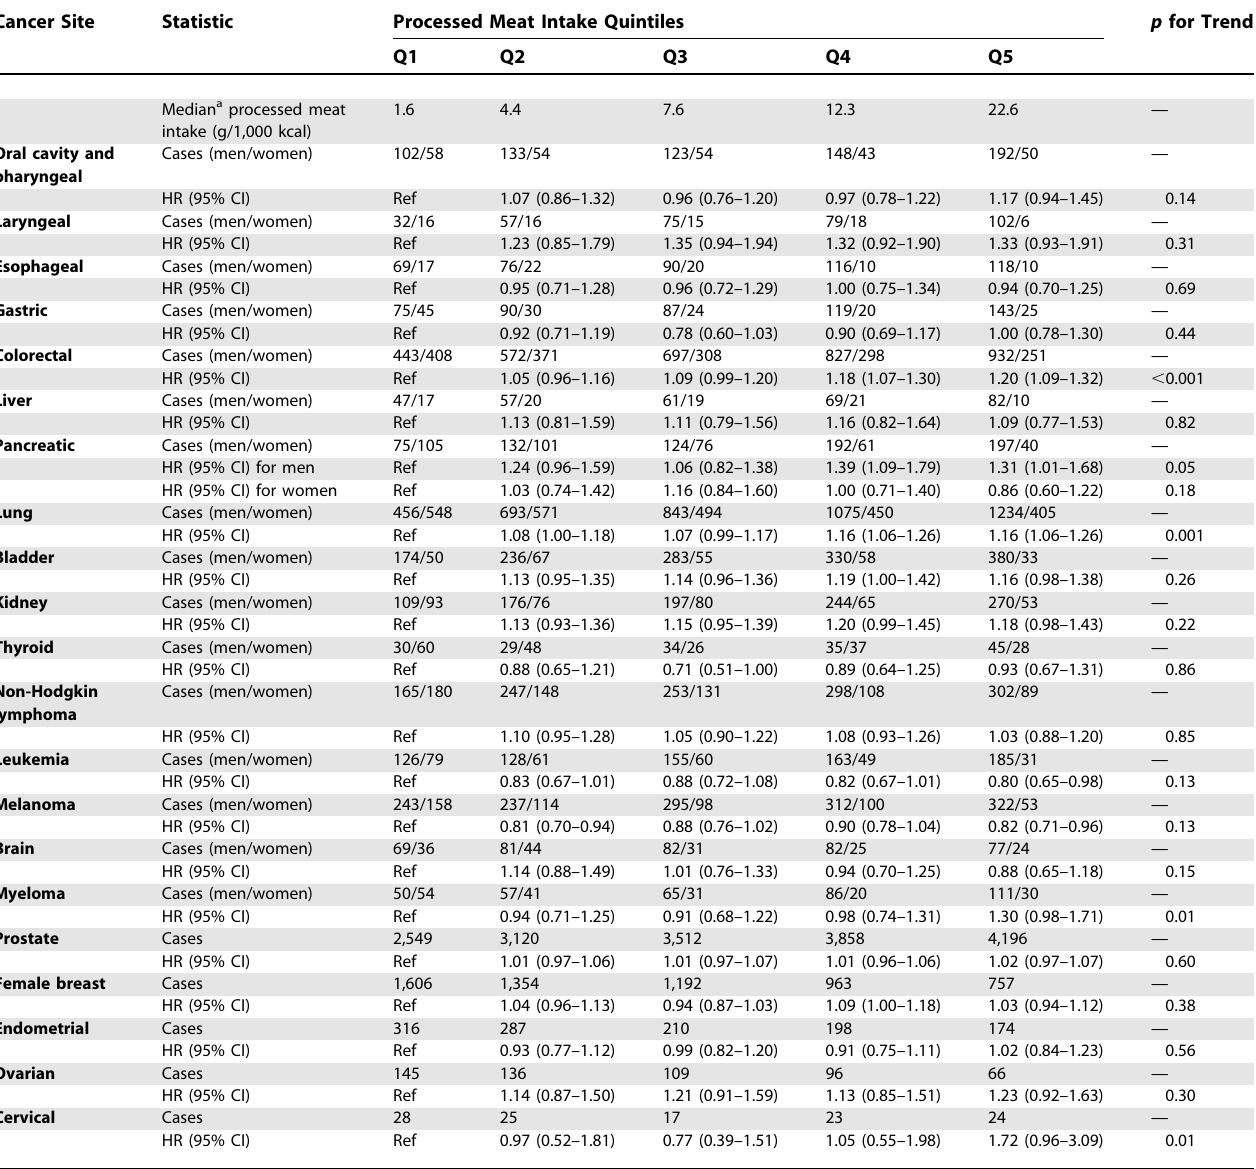
Table 3. Multivariate HRs and 95% CIs (Both Sexes Combined) for Processed Meat Intake and Cancer in the NIH-AARP Diet and